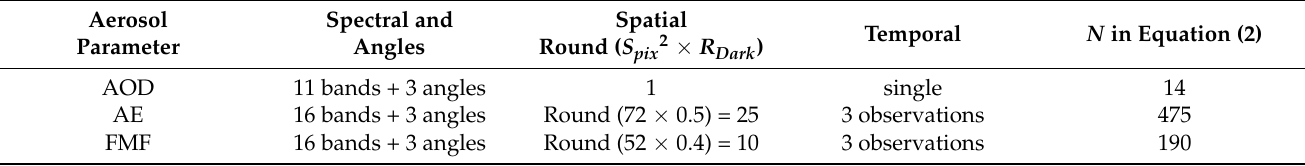
Table 2. The spectral, spatial and temporal parameters setting according to Equation